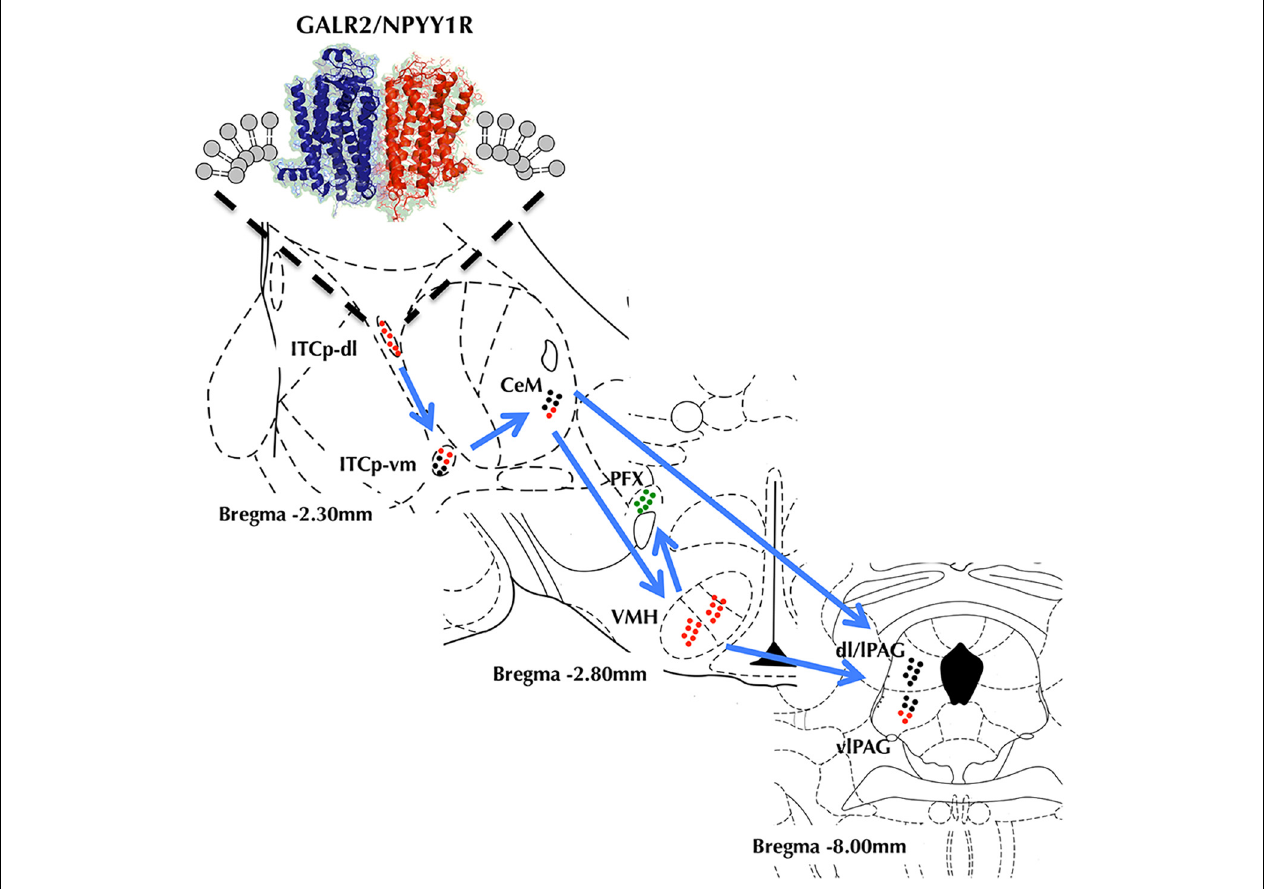
FIGURE 9 | Model diagram showing the relationship and circuit activity modifications on the amygdala-hypothalamus-PAG axis caused by coactivation of GALR2 and NPYY1R from upstream to downstream. GALR2/NPYY1R heteroreceptor complexes would inhibit activity in the dorsolateral cluster of medial paracapsular intercalated nucleus of the amygdala (ITCp-dl) inducing disinhibition of the ventromedial cluster of medial paracapsular intercalated nucleus of the amygdala (ITCp-vm) and reducing medial central amygdala (CeM) output. Thus, whereas ventromedial hypothalamus (VMH) gets inhibited, perifornical región (PFX) it is activated. Within the PAG, the ventrolateral región (vlPAG) gets a reduced activity. Color code (Green dots, Neuronal activation. Red dots, Neuronal inhibition. Black dots, No differences in neuronal